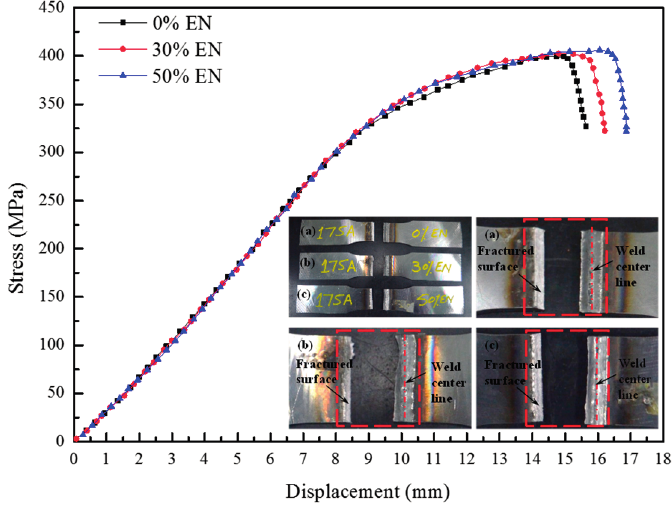
Figure 13. Stress vs. displacement at Ia of 175 A. The inset shows the fractured surfaces of the tested samples.